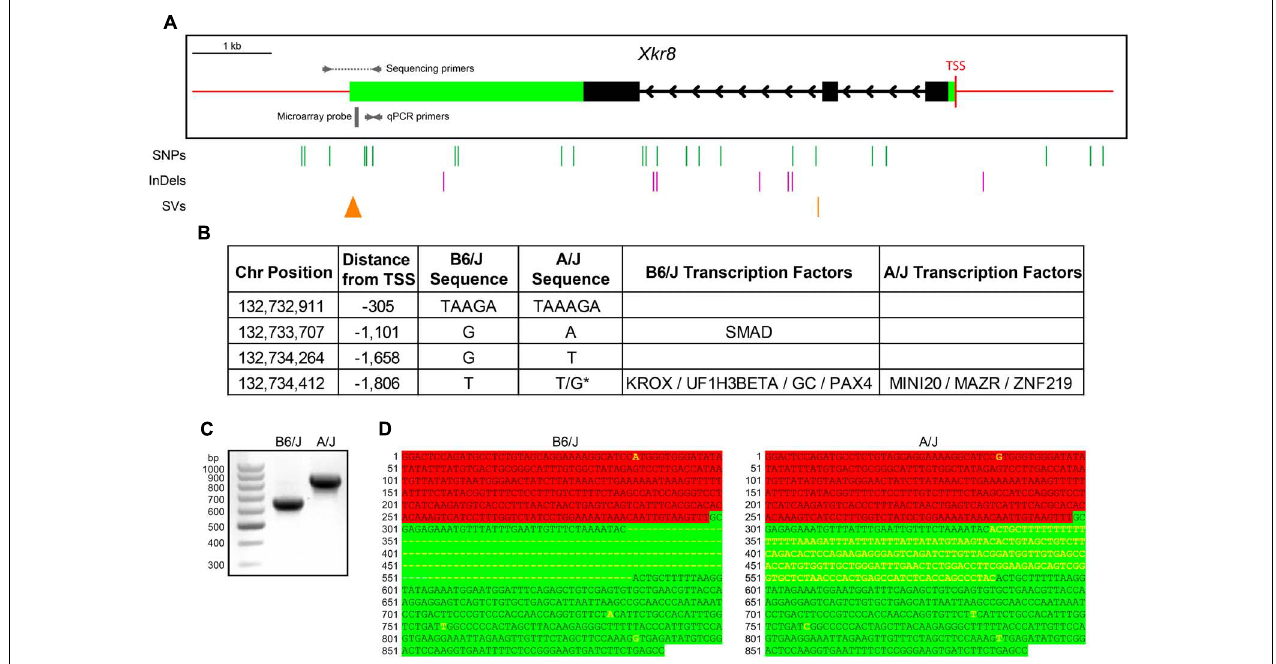
FIGURE 8 | (A) The Xkr8 gene has three exons (black boxes) and is ∼ 7,600 bp in size. 3 (cid:48) and 5 (cid:48) UTRs are denoted with green boxes and red lines indicate upstream and downstream regions. A/J and B6/J strains have multiple SNPs, InDels, and structural variants (SVs) within potential regulatory regions that discriminate their genomes (vertical lines). The 3 (cid:48) UTR SV is depicted as a triangle to indicate the relative size of the insertion. (B) Of the four upstream sequence variants, two of them establish binding sites for various transcription factors in one or the other sequence. (C,D) Amplification of the 3 (cid:48) end of Xkr8, using the sequencing primers indicated in (A) , confirms a 201 bp insertion in the A/J genome (C) , and sequencing of these amplicons localizes the structural variant to the 3 (cid:48) UTR of the gene (D) . Green and red highlighting indicate the 3 (cid:48) UTR and downstream regions, respectively, while the yellow lettering indicates variants between the strains. TSS, transcriptional start site. ∗ Heterozygous